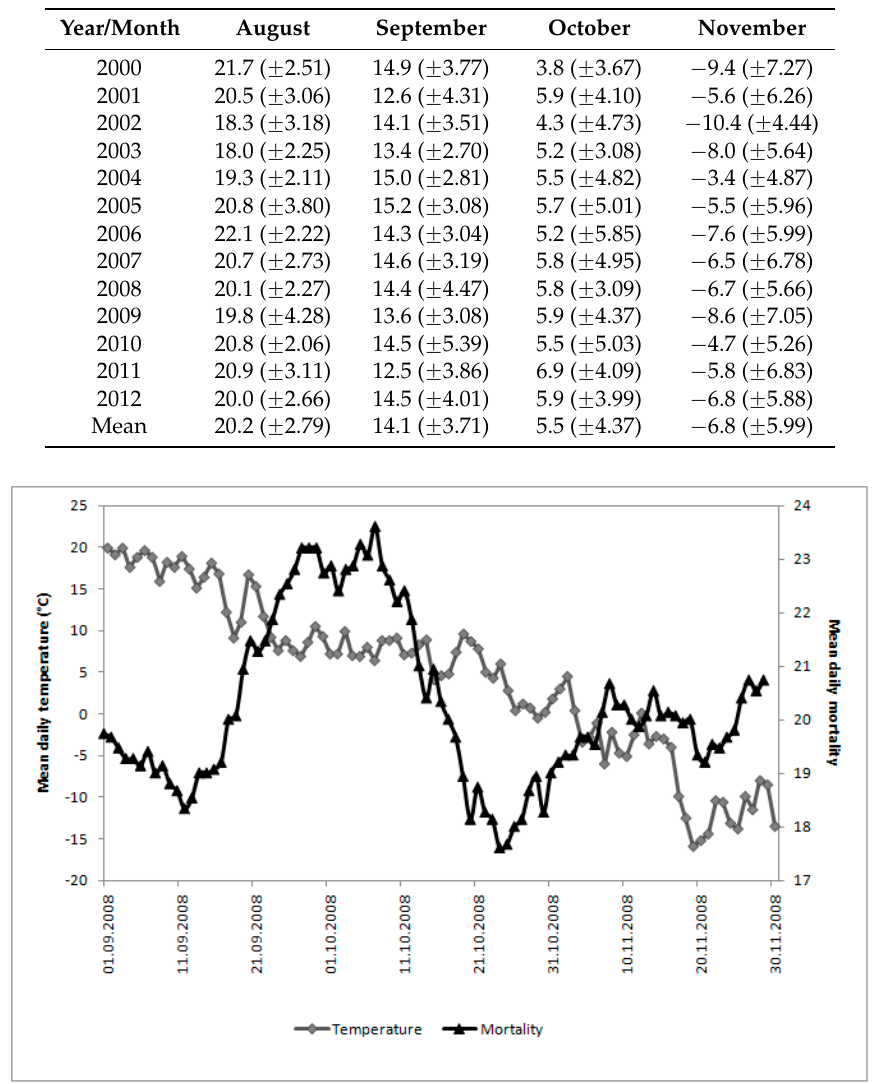
Table 1. Mean monthly air temperature and standard deviation (°C) for autumn (September to November) and the preceding month for Khabarovsk, 2000–2012.